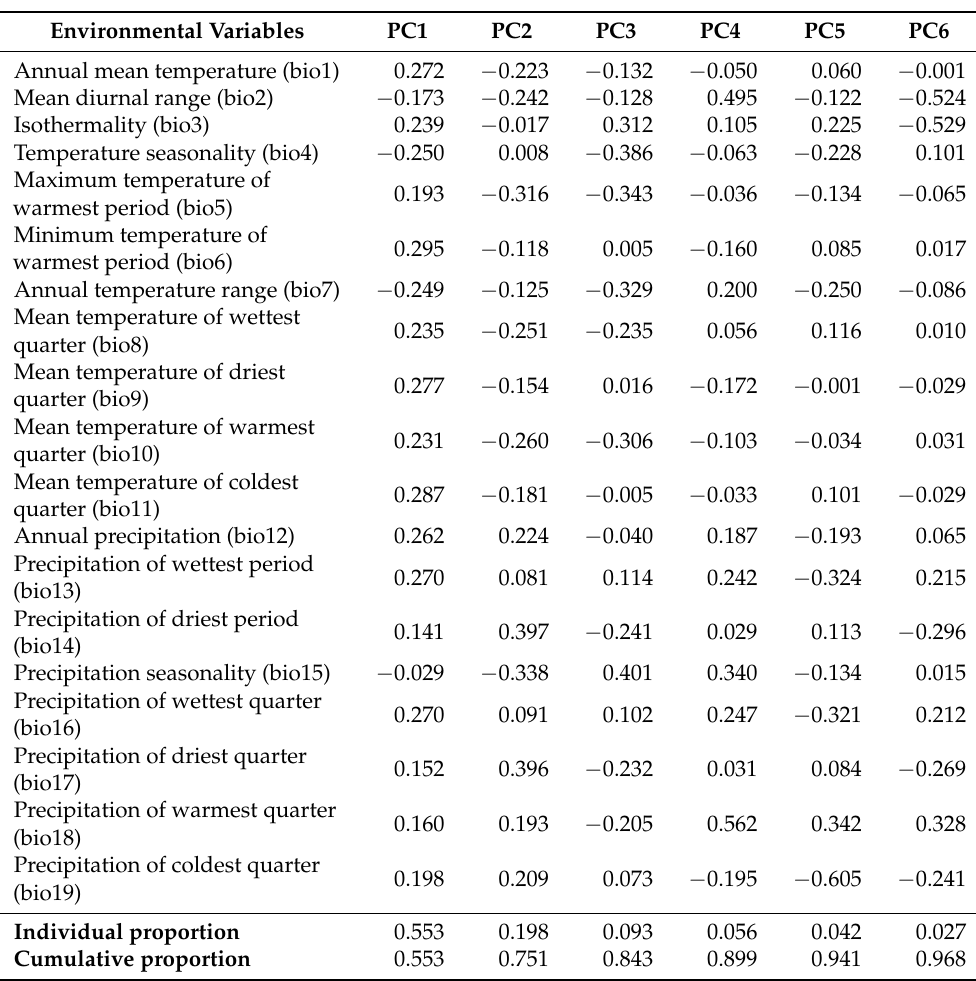
Table 1. Summary of the PCA from which the principal components (PC) used as new environmental layers were generated. Each cell value represents the individual loadings of each variable in each of the PCs. The PCs, along with their individual and accumulated proportions, are also